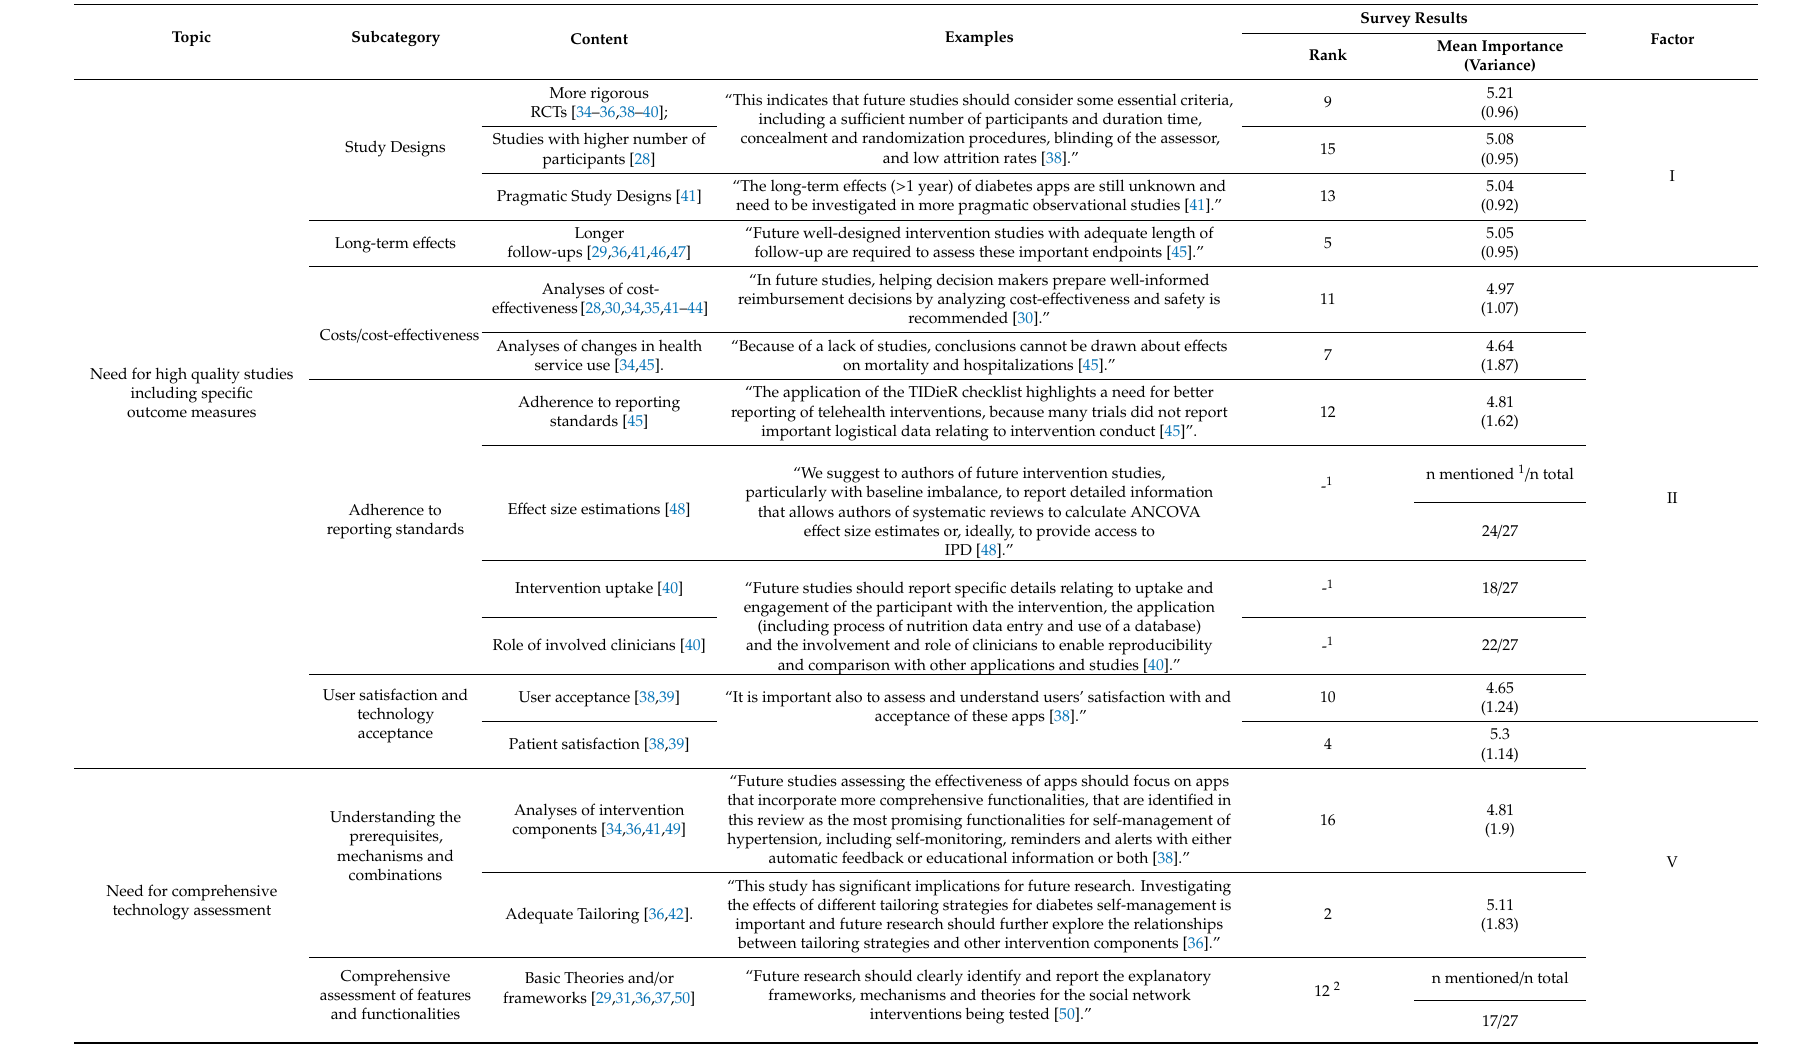
Table 1. Joint display of qualitative and quantitative